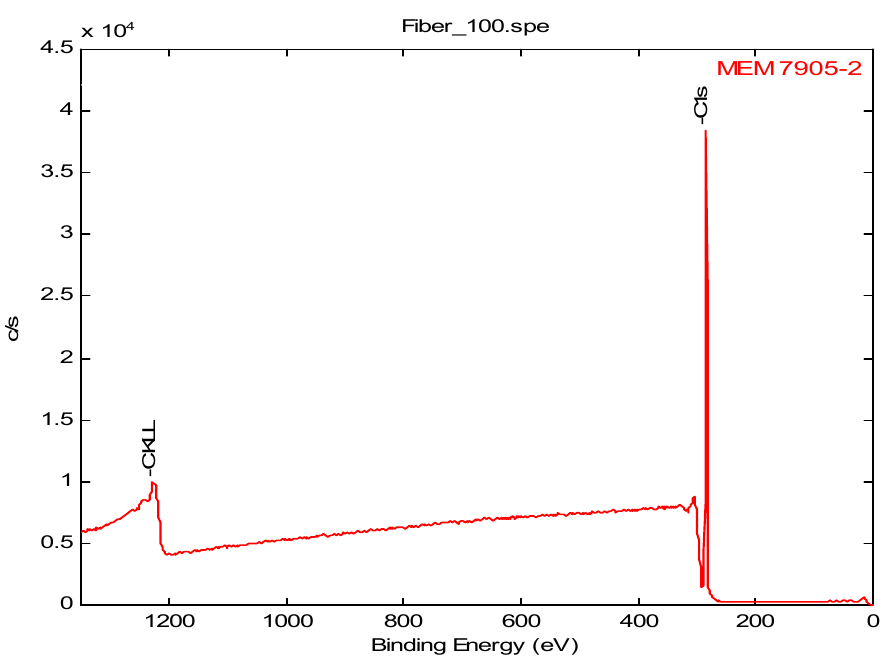
Figure 8. XPS spectrum of the Uncoated PP150/330 membrane. Table 14. Effect of heat aging at 90–100 ◦ C for 90 min on gas permeance of membranes made from TMDSO and HMTSO plasma